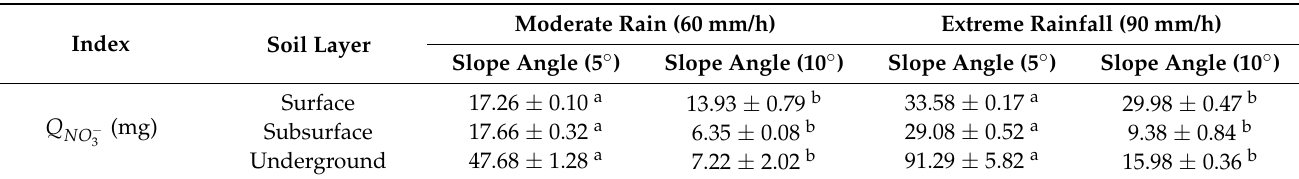
Table 6. Nitrate-nitrogen loss per hour per square meter of sloping farmland.